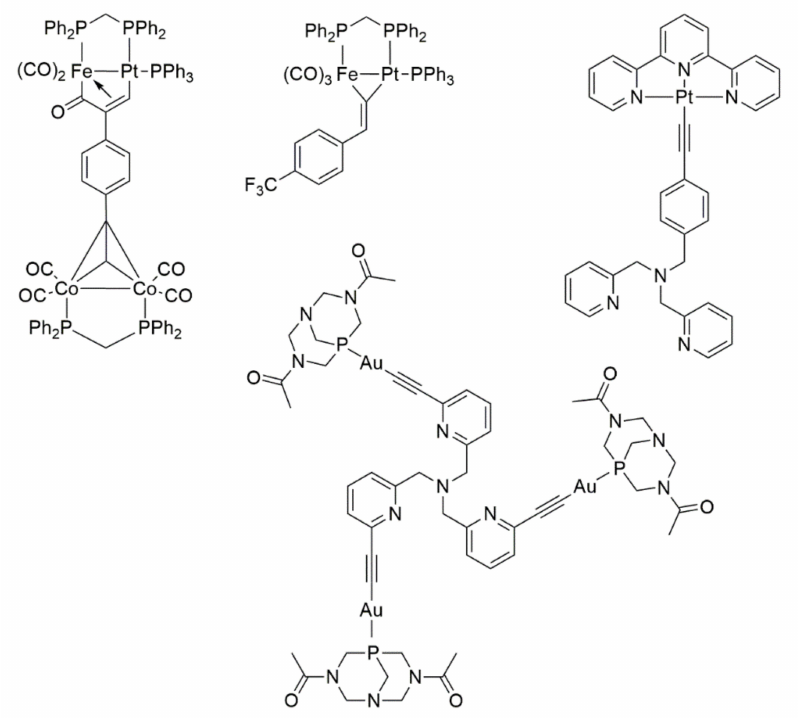
Figure 3. Selected examples [13–16] of coordination compounds obtained from alkyne-containing molecules.